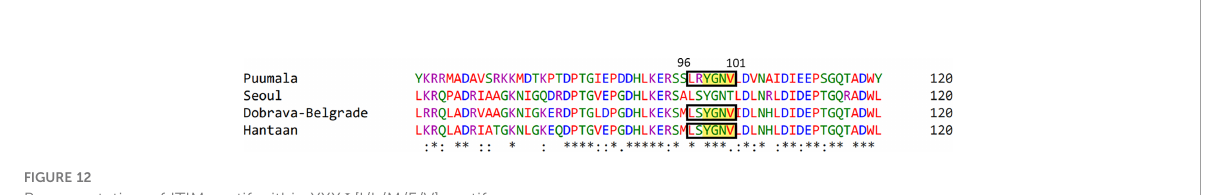
FIGURE 12 Representation of ITIM motif within YXX F [I/L/M/F/V]